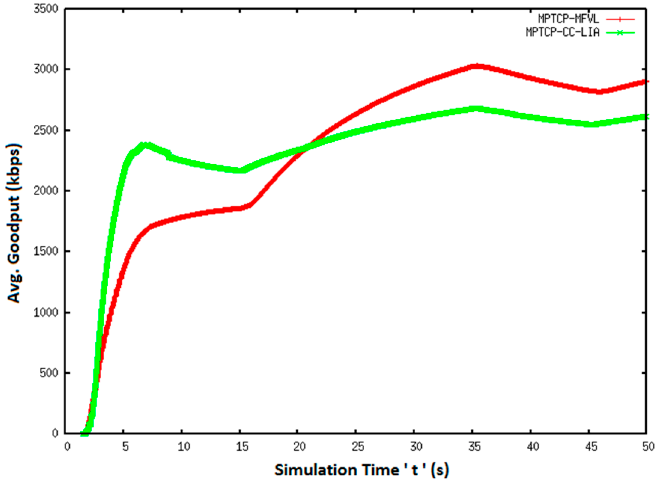
Figure 10. Average goodput result of Setup 2.